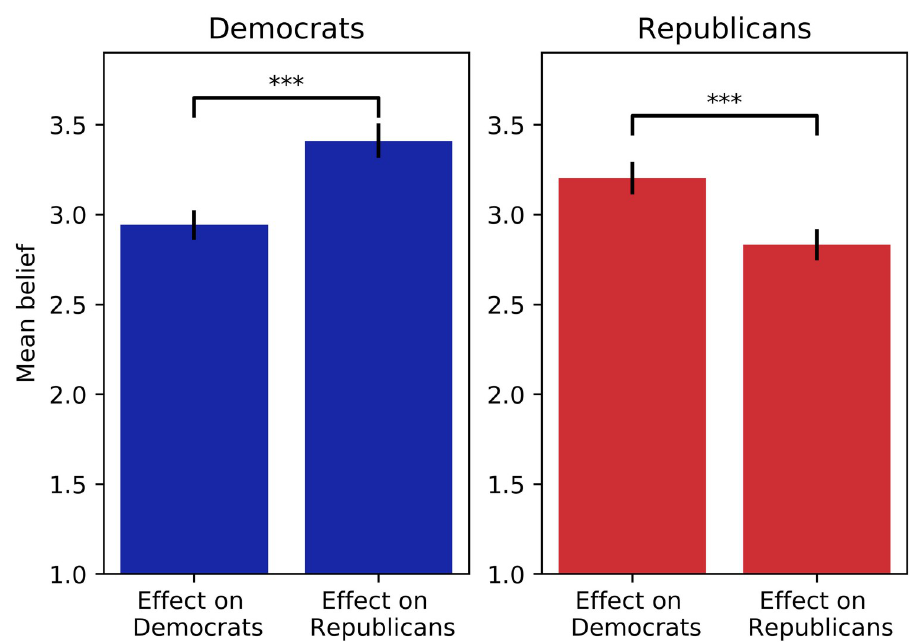
Fig 1. Beliefs about the effect of online targeted political advertising. Participants’ beliefs about the effect of online targeted political advertising on Democrats and Republicans. Beliefs are measured on a five-point Likert scale (1 = “not at all”, 5 = “to a very great extent”). The bars show 95% confidence intervals. � p < 0.05, �� p < 0.01, ��� p < 0.001.